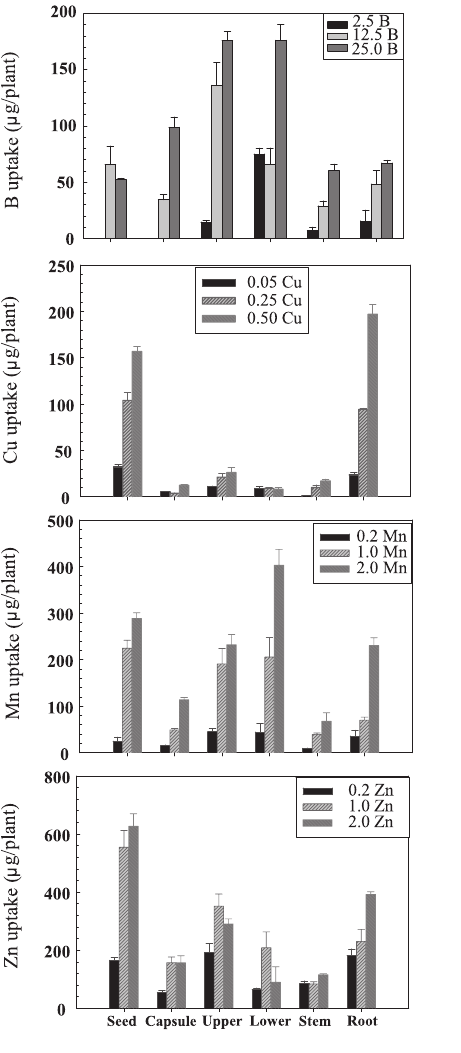
figure 2. Uptake and distribution of boron, copper, manganese and zinc in the components of the shoot and root, considering the levels (µmol l -1 ) of b, cu, mn and Zn to castor bean hybrid “iris” grown in a nutrient solution. bars represent the standard error of the